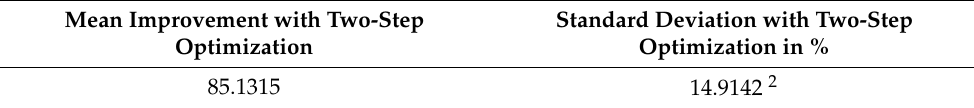
Table 5. Mean and standard deviation improvement related to one differential evolution optimiza- tion. Mean Improvement with Two-Step Standard Deviation with Two-Step Optimization